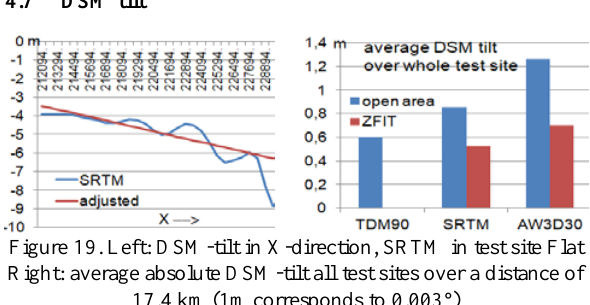
Figure 19. Left: DSM-tilt in X-direction, SRTM in test site Flat Right: average absolute DSM-tilt all test sites over a distance of 17.4 km (1m corresponds to 0.003°)